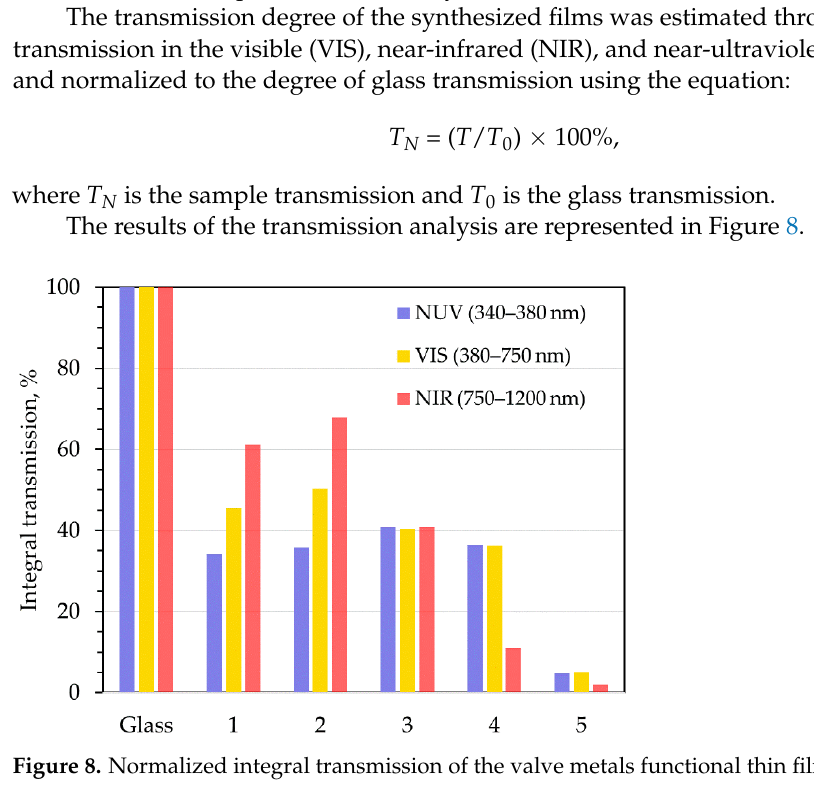
and normalized to the degree of glass transmission using the equation: